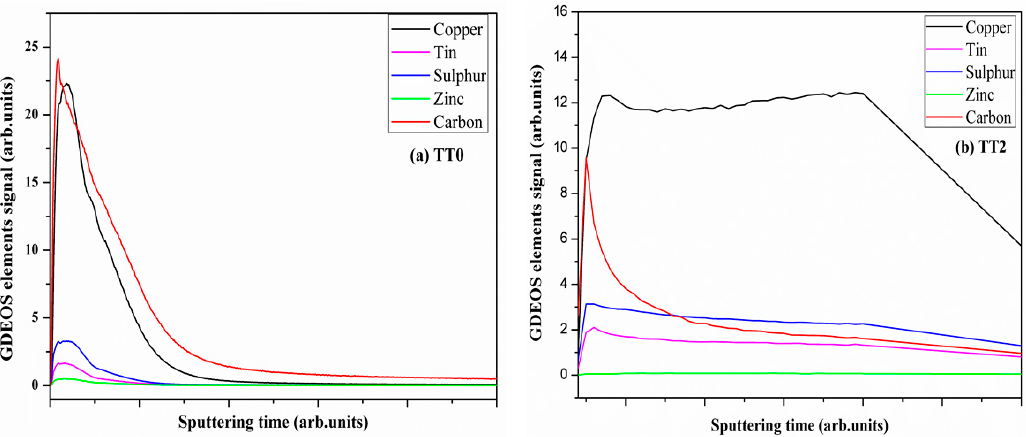
Figure 6. GDOES depth profiles (raw data) of CZTS elements and carbon measured after ( a ) the soft treatment (TT0) on a thin film (100 nm) and ( b ) after the high temperature thermal treatment (TT2) of a regular (circa 1.5 µ m) layer performed in inert and sulphur atmosphere.